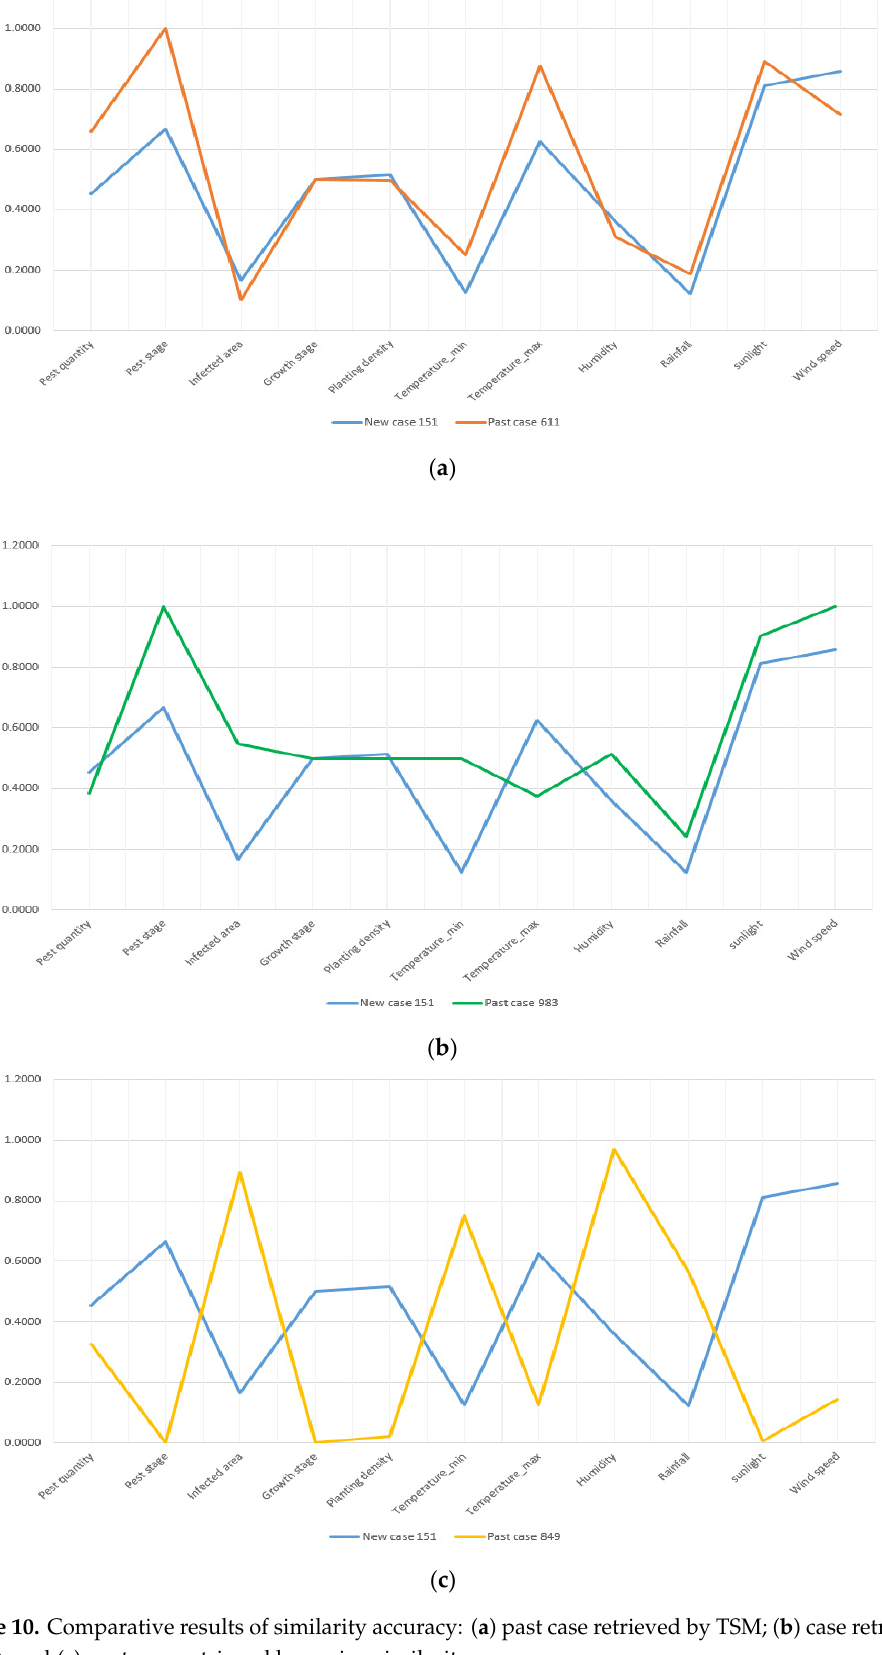
Figure 10. Comparative results of similarity accuracy: ( a ) past case retrieved by TSM; ( b ) case retrieved by ED; and ( c ) past case retrieved by cosine similarity measure.